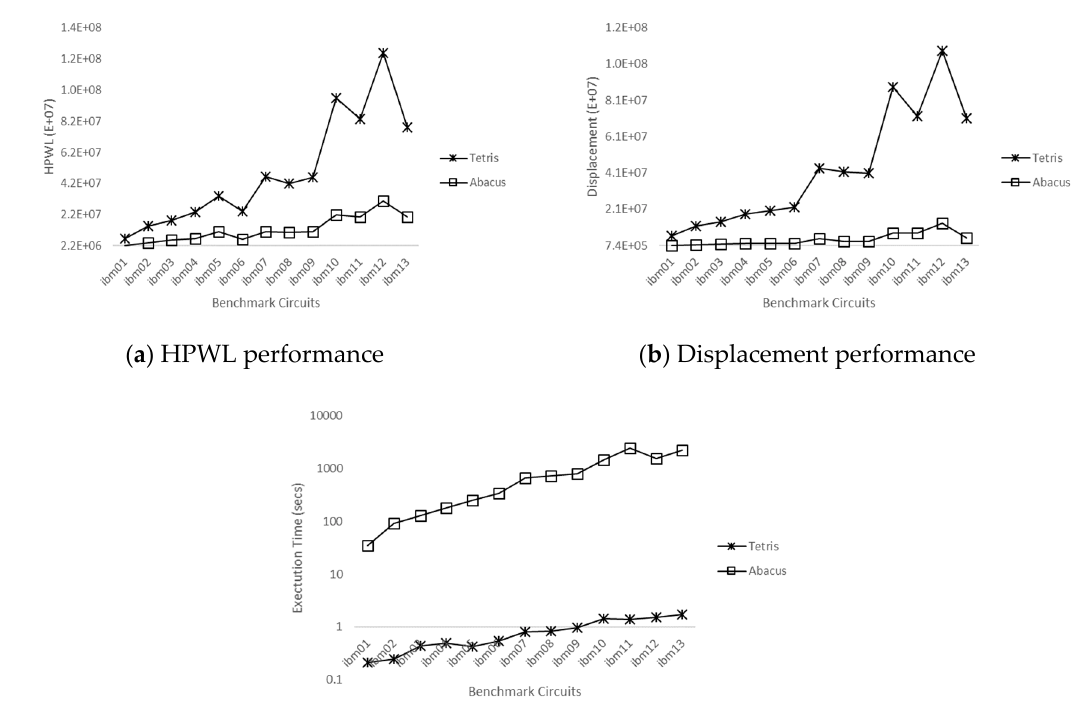
Figure 4. Performance comparison standalone Tetris and Abacus. HPWL—half perimeter